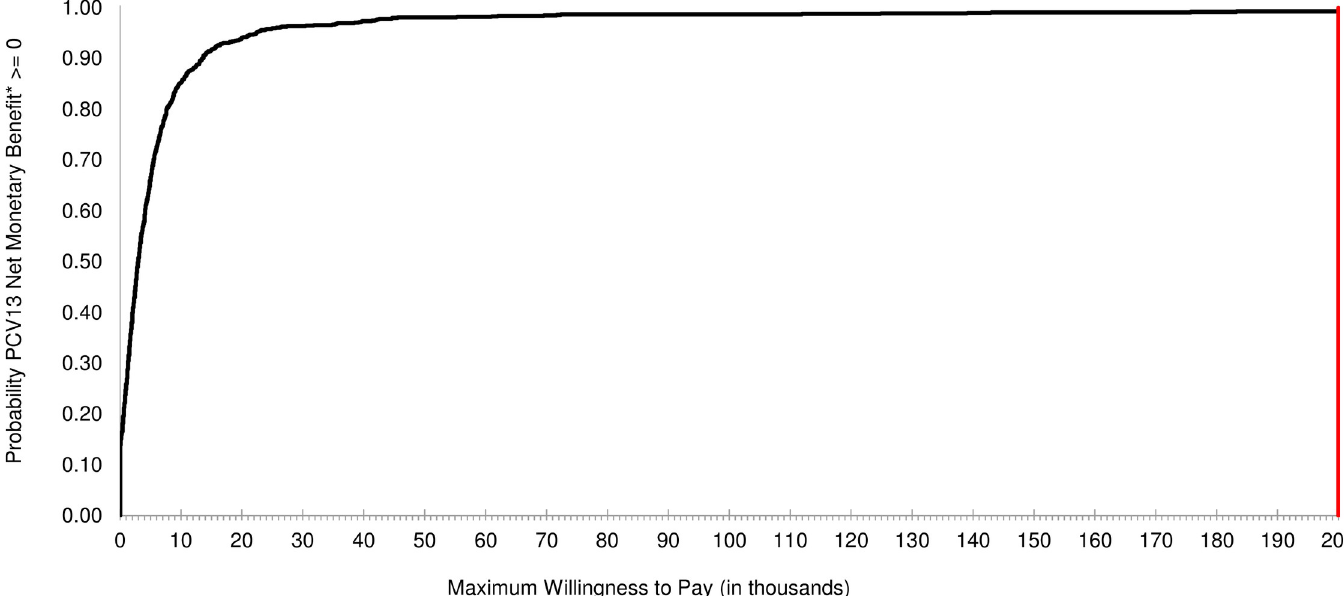
Fig 10. Cost-effectiveness acceptability curve: Public health care sector HIV-infected model. Costs are indicated in 2015 South African rand.